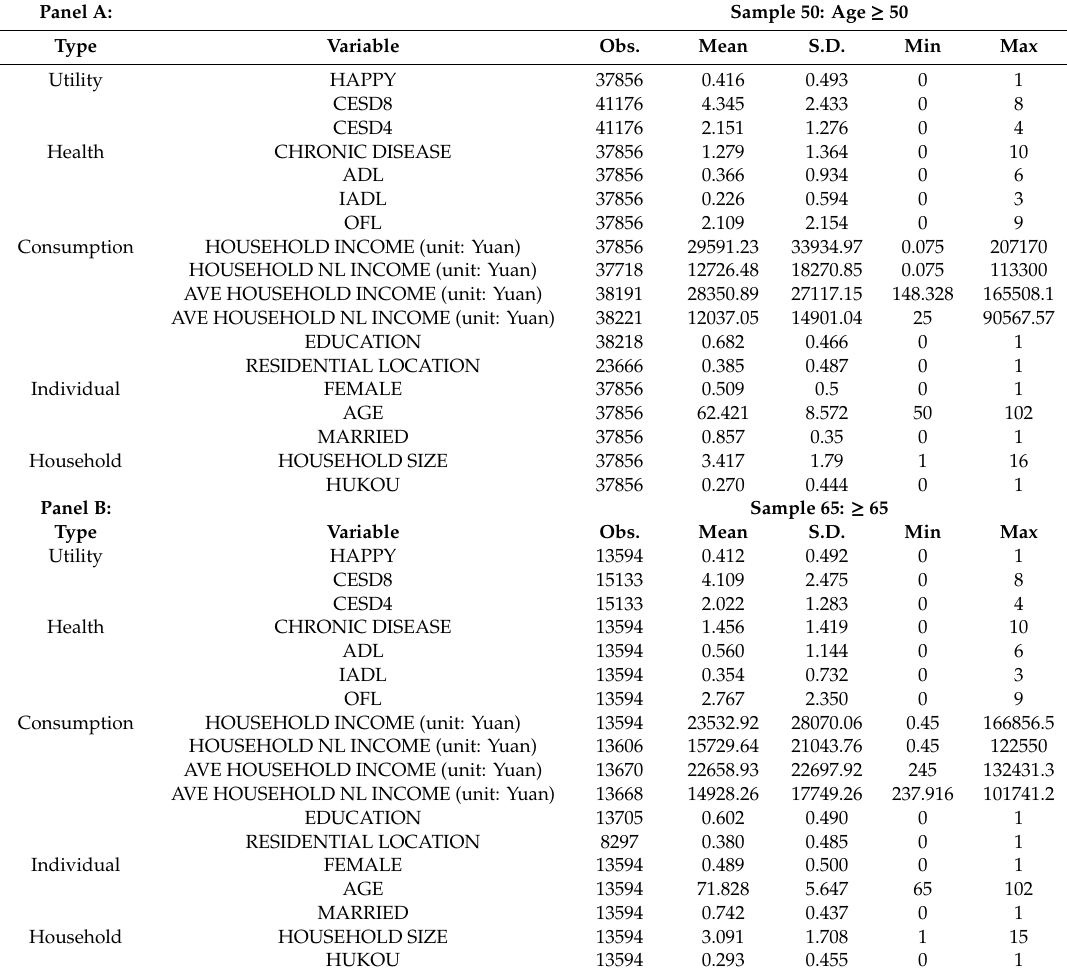
Table 1. Summary statistics of